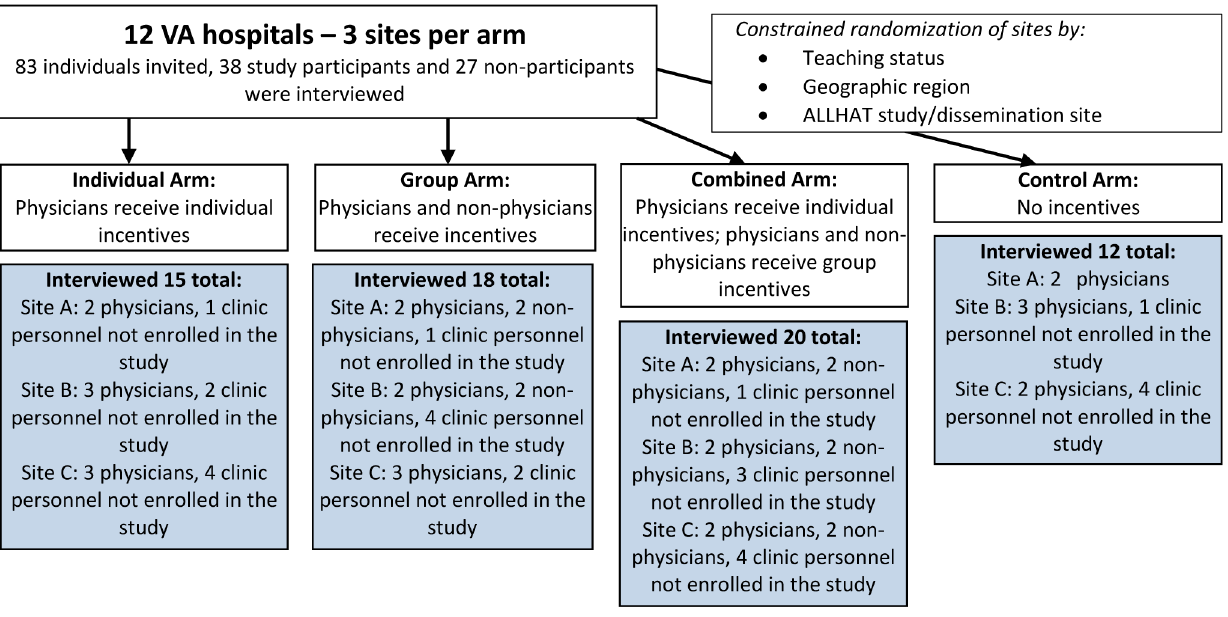
Fig 1. Randomized controlled trial